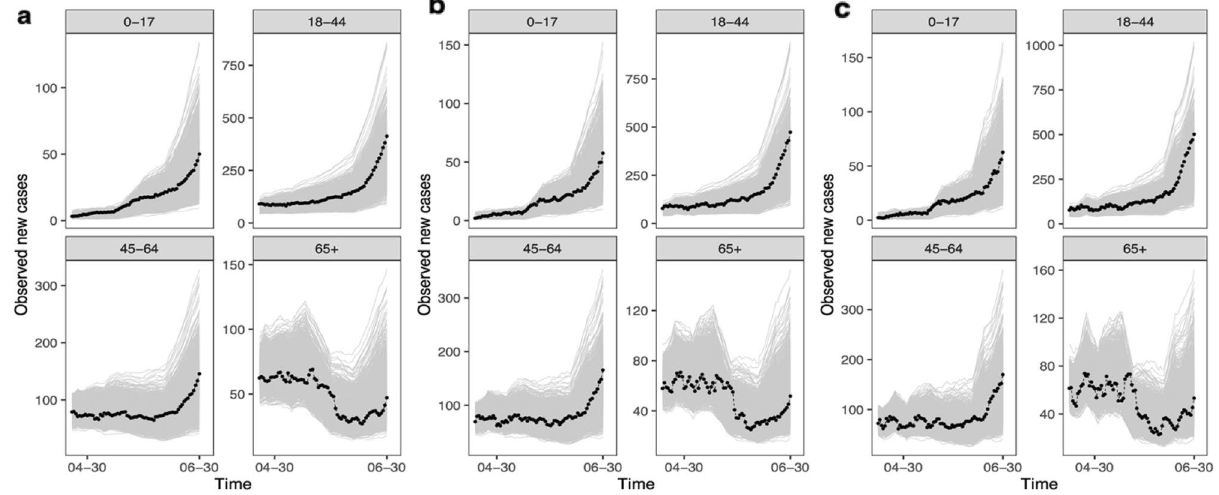
Figure 4. Model fit. ( a ) Daily (14-day moving) average computed from observed daily new cases among different age groups are shown in dotted lines. Grey lines represent the same average computed from 1,000 set of observations simulated from our estimated model. ( b ) Daily (10-day moving) average. ( c ) Daily (7-day moving)